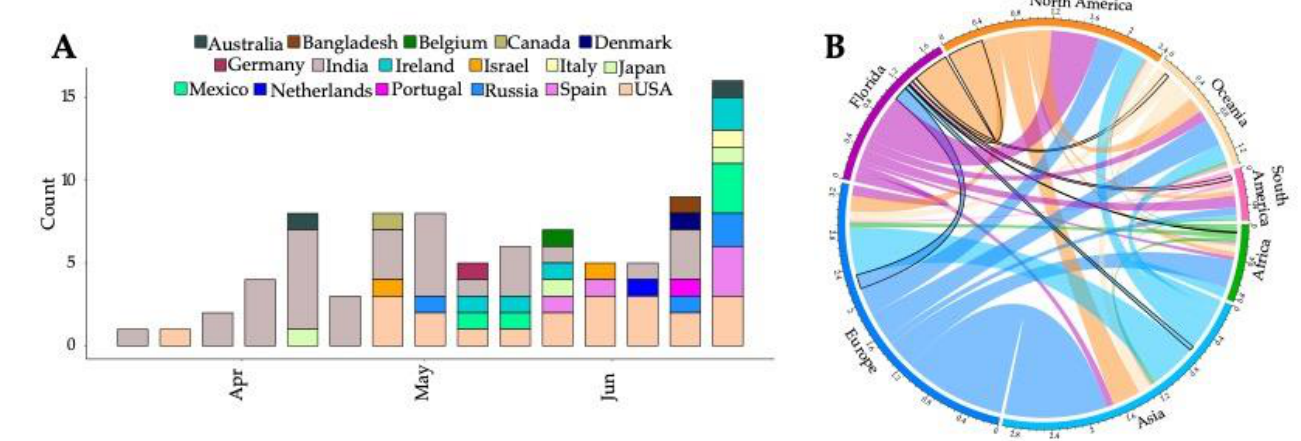
Figure 3. Sources of viral exchanges (imports and exports) in and outside Florida. Movement was inferred using ancestral reconstruction of geographic states within the phylogenetic tree of genomic samples. ( A ). Total number of viral introductions over time into Florida. ( B ) . Graphical representation of the estimated number of migration events between the geographic areas; introductions into the state of Florida are outlined in black.